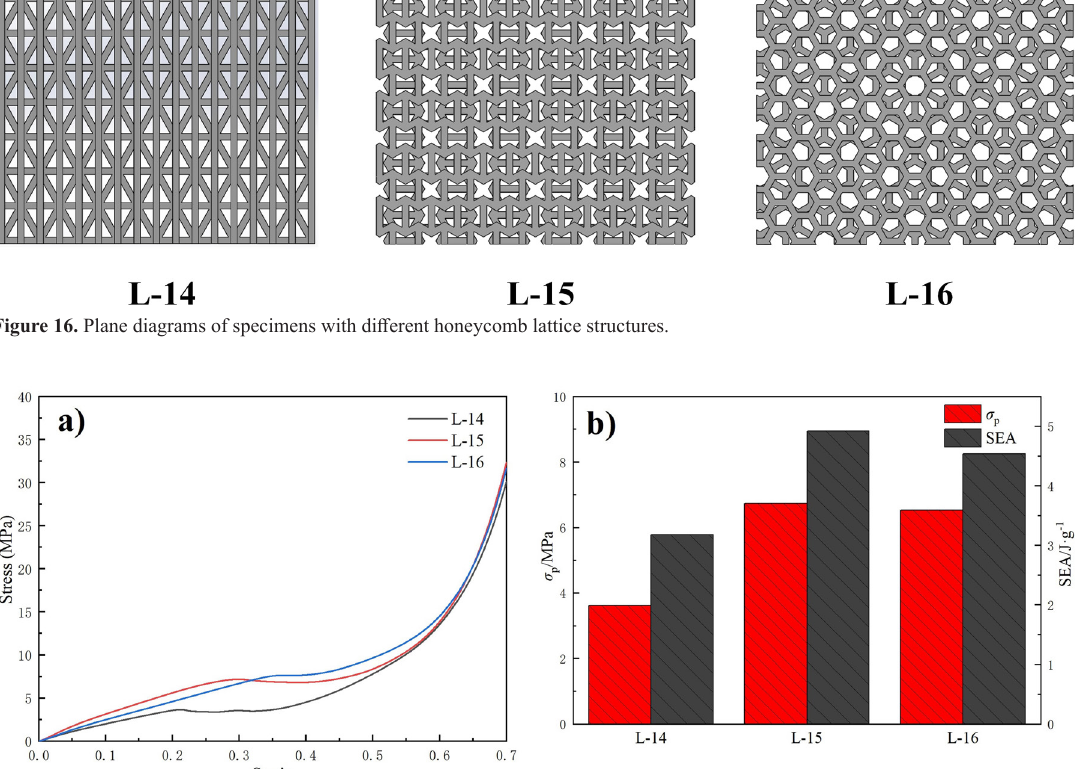
Figure 17. a) Stress-strain curves of different honeycomb lattice configurations, b) Platform stress and SEA of different honeycomb lattice